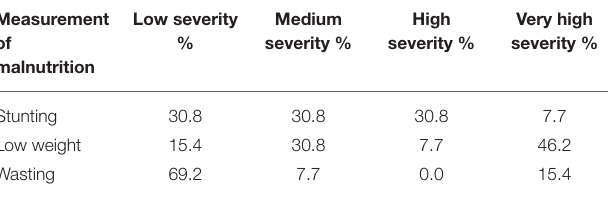
TABLE 6 | The percentage of communities measured ( n = 13) experiencing different levels of severity for child malnutrition (under age 5) on the Masoala Peninsula (2015) using WHO standards (2017).